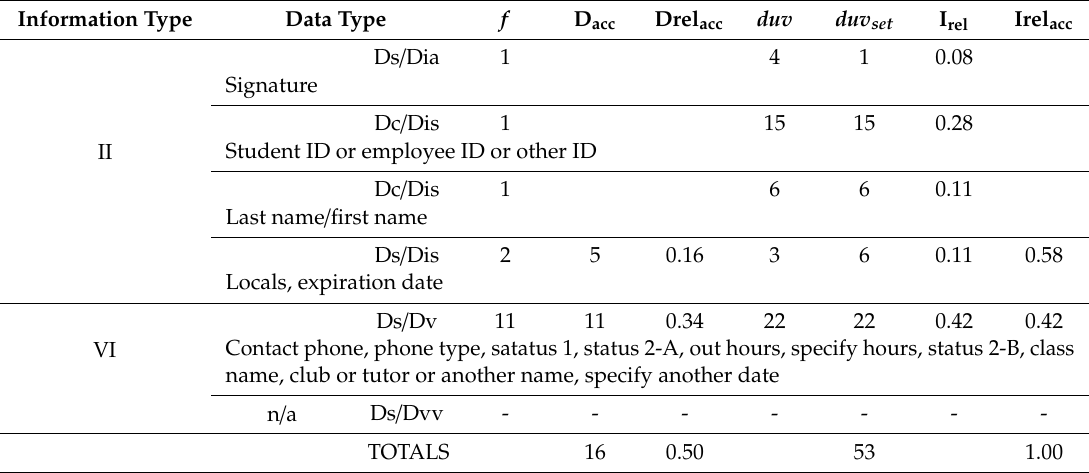
Table 4. Data classification and its transformation into information, frequency of accumulated data according information type zone (D acc ), relative frequency of accumulated data according information type zone (Drel acc ), information relative value (Irel), and accumulated information relative value (Irel acc ) for the F1–01